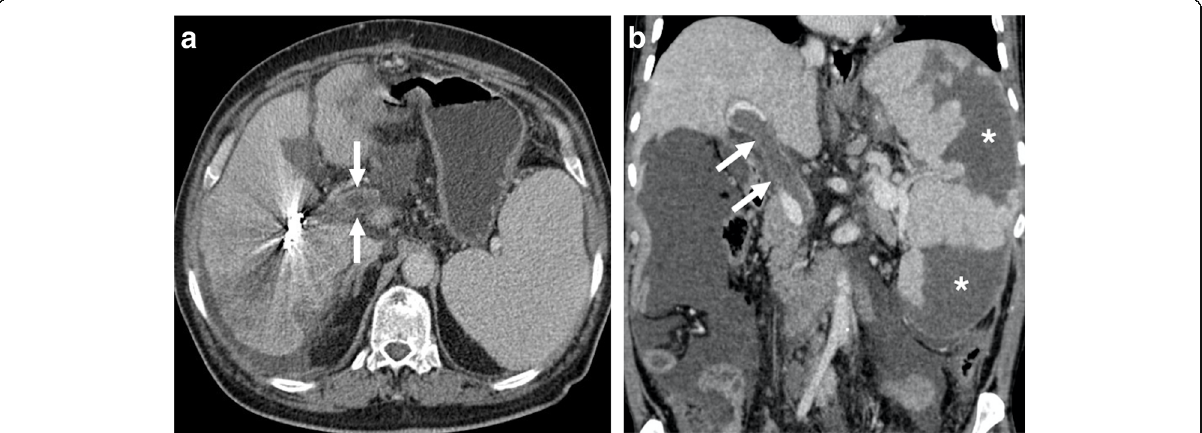
Fig. 2 Two patients with iatrogenic portal vein thrombosis. a A 65-year-old male with known HCC underwent selective right portal vein embolization for surgical resection. The patient presented with severe epigastric and right upper quadrant pain 14 days after the procedure. Axial post-contrast abdominal CT image demonstrated acute main portal vein thrombosis (arrows). Also, note metallic artifacts in the right liver lobe secondary to embolization coils. b A 55-year-old male with known Hodgkin lymphoma underwent splenic artery embolization because of pancytopenia induced by hypersplenism presents with persistent right upper quadrant pain and elevated liver enzymes. Coronally reformatted post-contrast abdominal CT image demonstrated diffuse portal vein thrombosis (arrows). Also, note is made of diffuse splenomegaly and extensive parenchymal infarcts